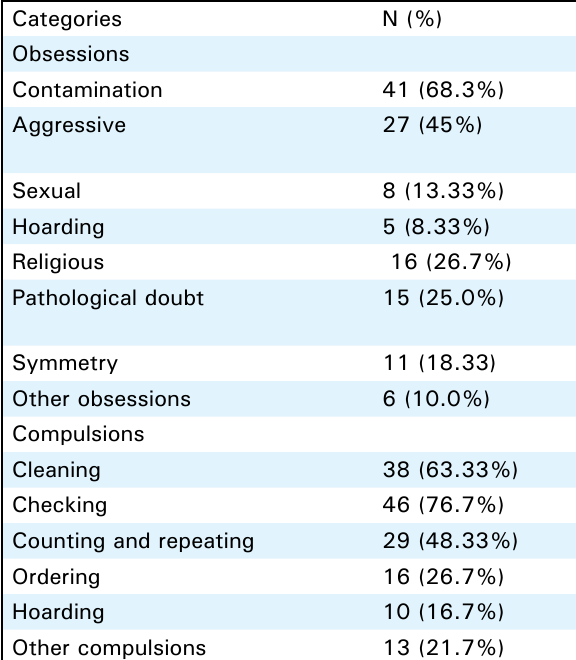
table 1. Lifetime presence of symptoms from the Y-bOcs